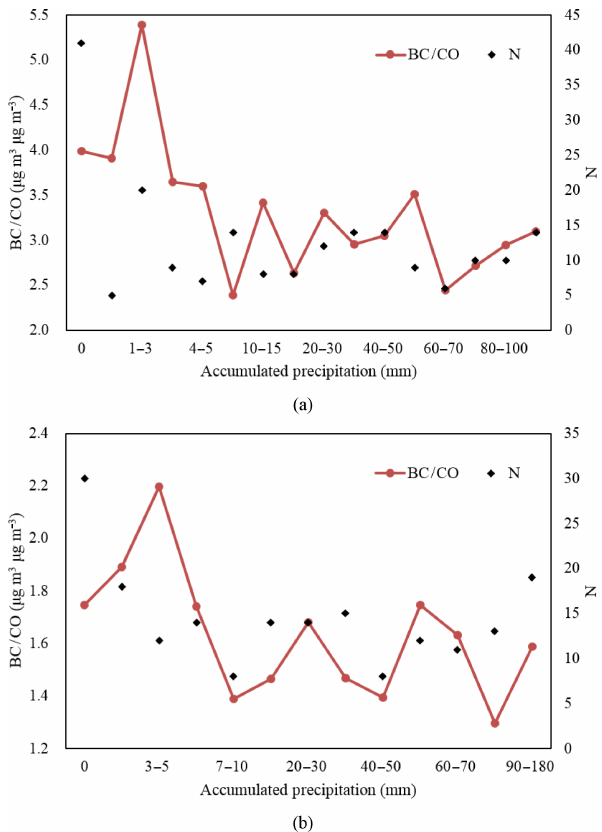
Figure 8. The (cid:49) BC /(cid:49) CO ratio at NJU (a) and PAES (b) separated by different accumulated precipitation along the back trajectories during 48h. The data point number of each accumulated precipita- tion interval (right axis) is also